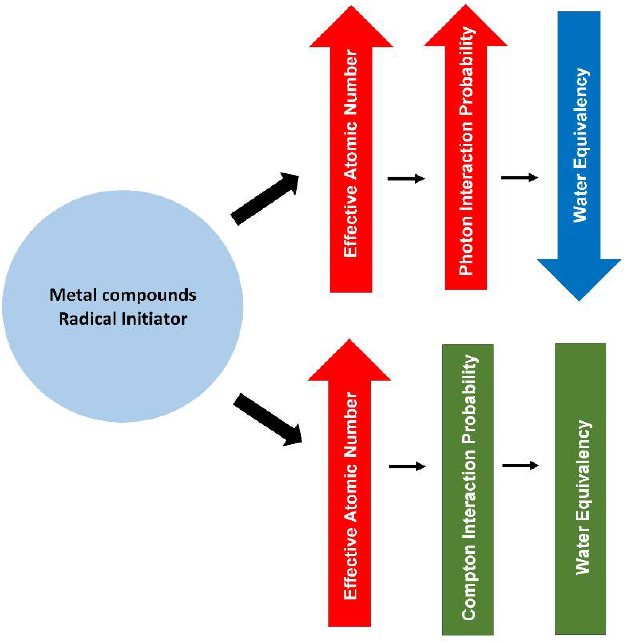
Figure 4. A diagram summarising the effect of metal compounds and radical initiator on the radiological properties of PRESAGE.